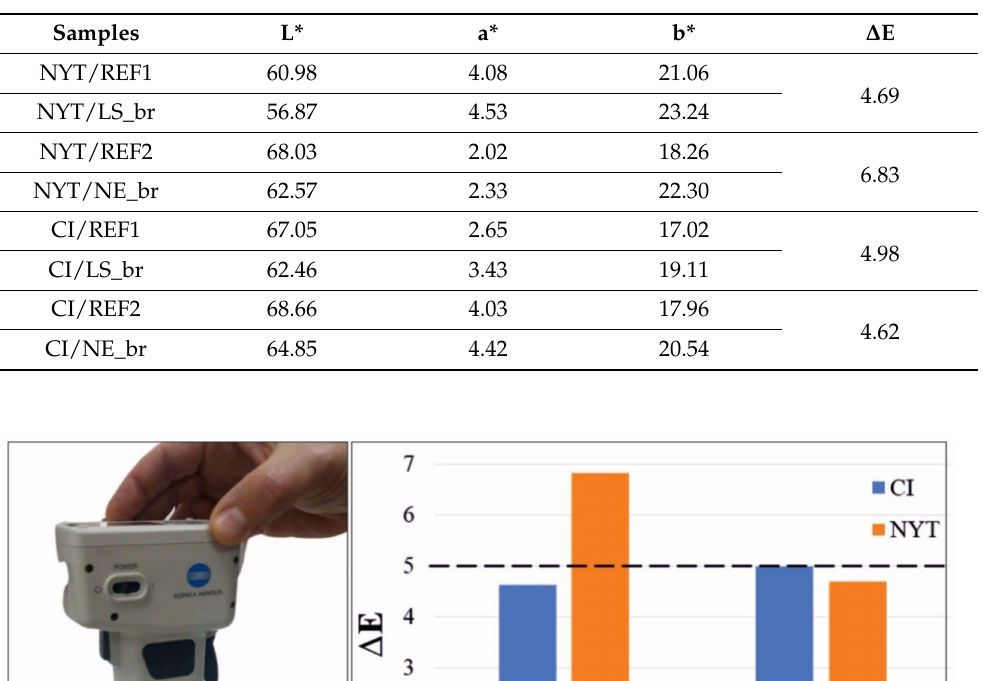
Table 7. Chromatic modifications of tuff stones after brushing treatment. L*: black-white color; a*: red-green color; b*: yellow-blue color; ∆ E: color change.